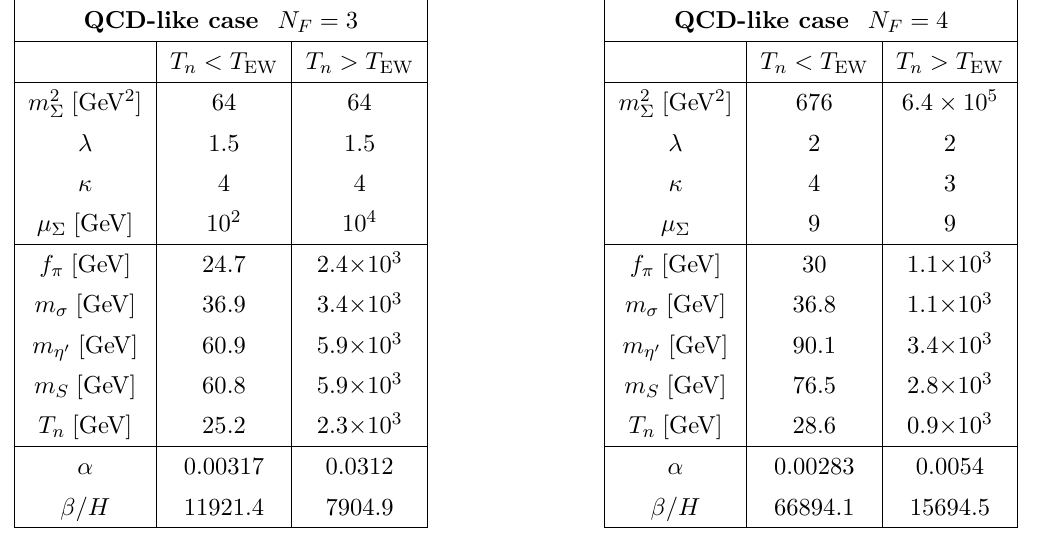
= 3 and N = 4 for the QCD-like F F